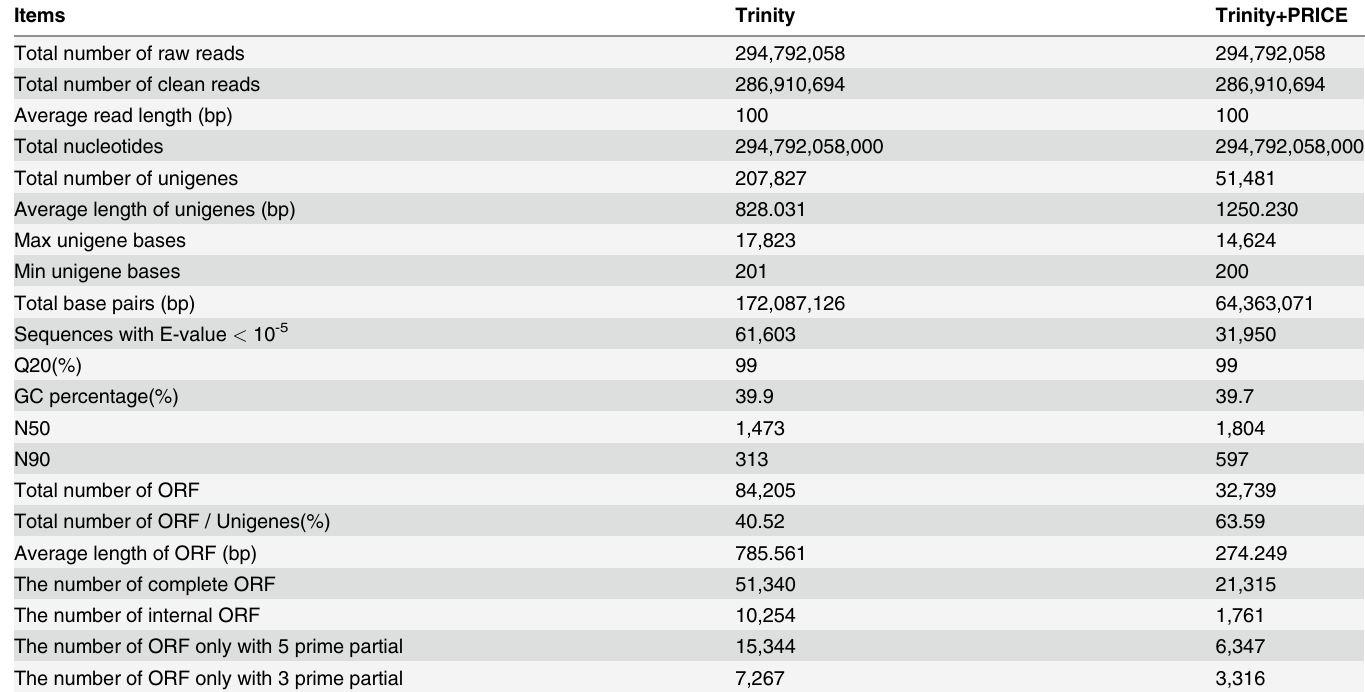
Table 2. Statistical summary of ‘ Hangbaishao ’ dormant bud transcriptome by Illumina RNA-Seq platform.